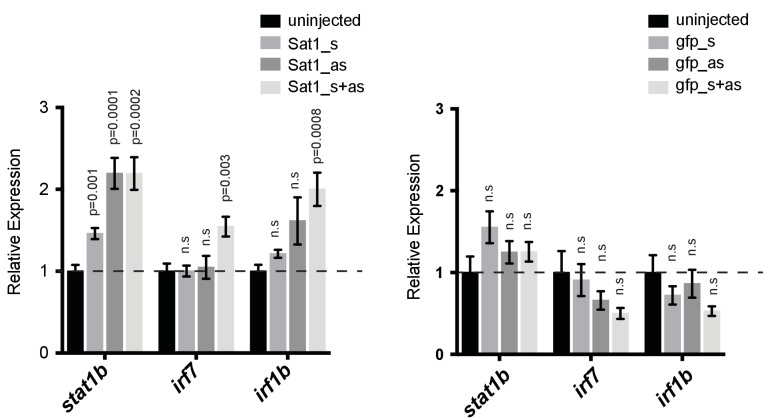
Effect of injecting in vitro transcribed Sat1 RNAs on expression of interferon stimulated genes.Expression of interferon stimulated genes in wild-type embryos injected with sense (Sat1_s), anti-sense (Sat1_as) or an equimolar mixture of sense and anti-sense Sat1 transcripts (Sat1_s + as). Transcripts of similar size encoding a fragment of GFP are used as a control. 50 pg of in vitro transcribed transcripts were injected into wild-type zebrafish embryos at the 1 cell stage. Total RNA was extracted at 8 hr post fertilization for qRT-PCR analysis. Error bars indicate SEM from 4 to 8 biological replicates with n = 20 embryos for each biological replicate. p-values are adjusted for multiple comparisons using the Holm-Sidak method, tested against uninjected control. n.s: Not significant.